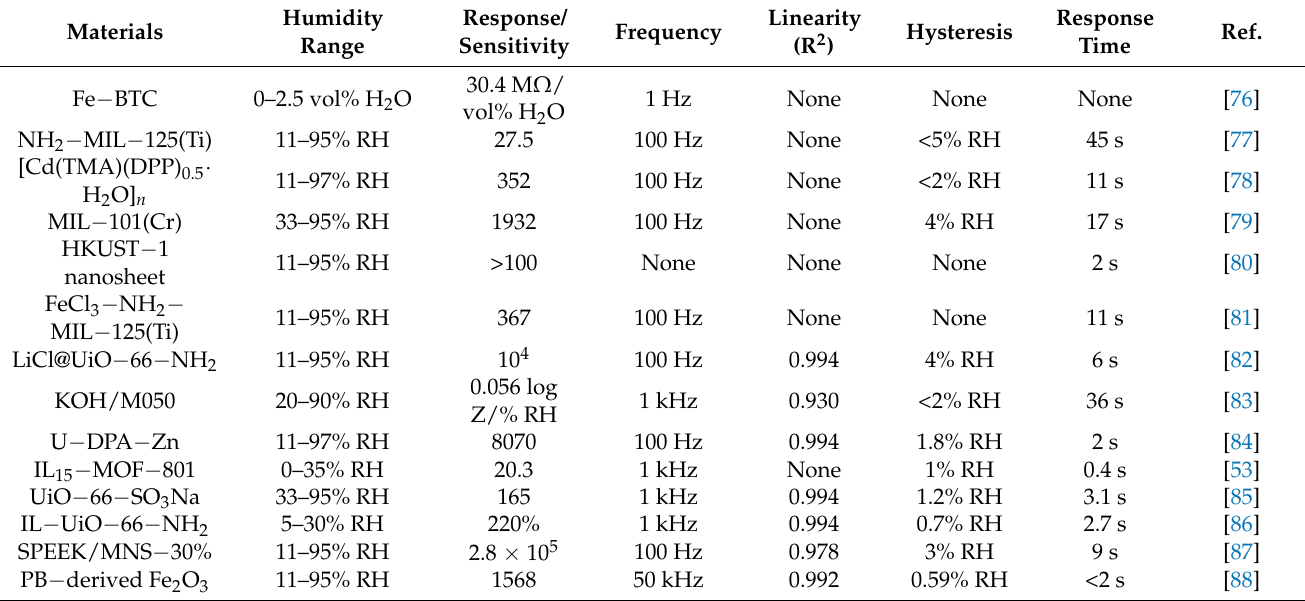
Table 1. Sensing properties of MOF − based impedance − type humidity